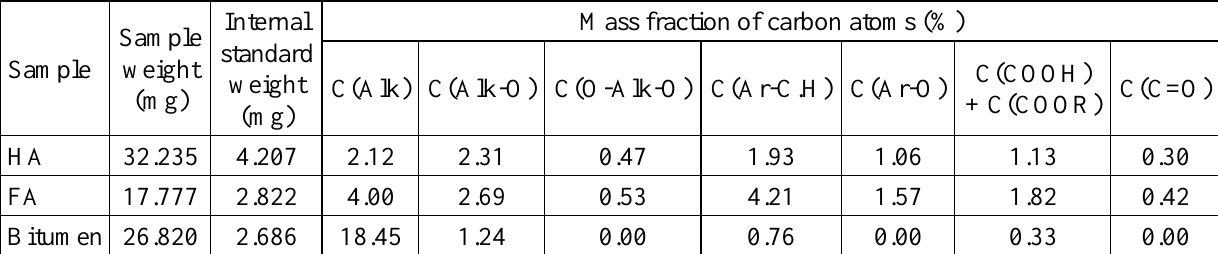
Table 6. Mass fraction of carbon (C) in the different functional groups of peat components (from NMR analysis).